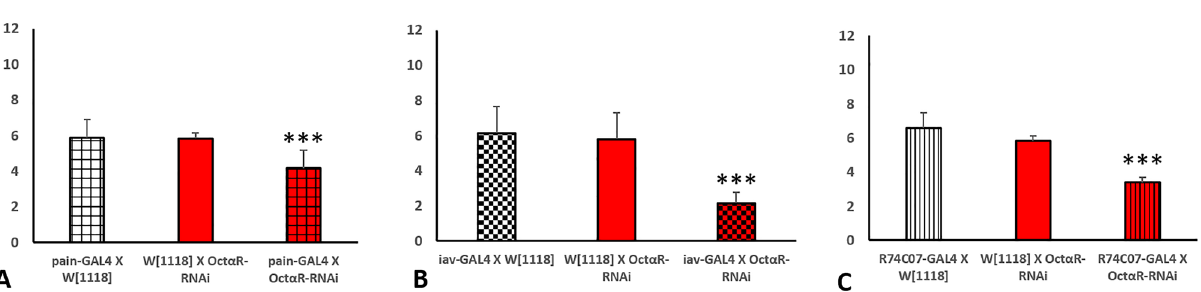
Figure 5. Negative geotaxis assay of adult male flies (N = 10) that lost the expression of octαR using specific mechanoreception GAL4 driver lines . Asterisks indicate significant differences among treatments (Student